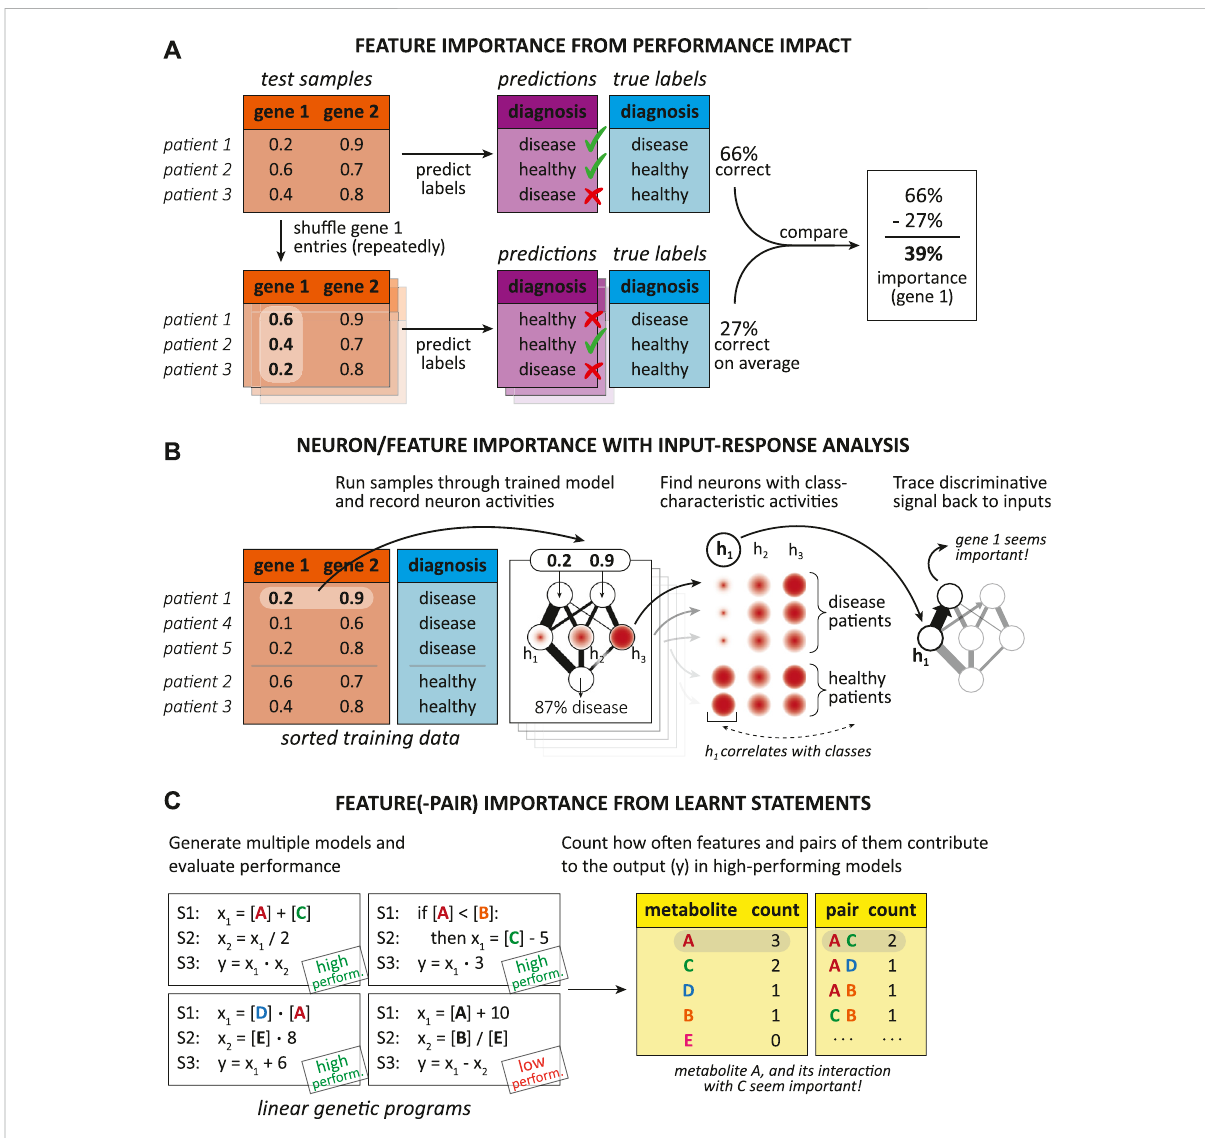
FIGURE 5 Examplesofpost-hocinterpretationmethodsfromSection4.3insimpli fi edform. (A)